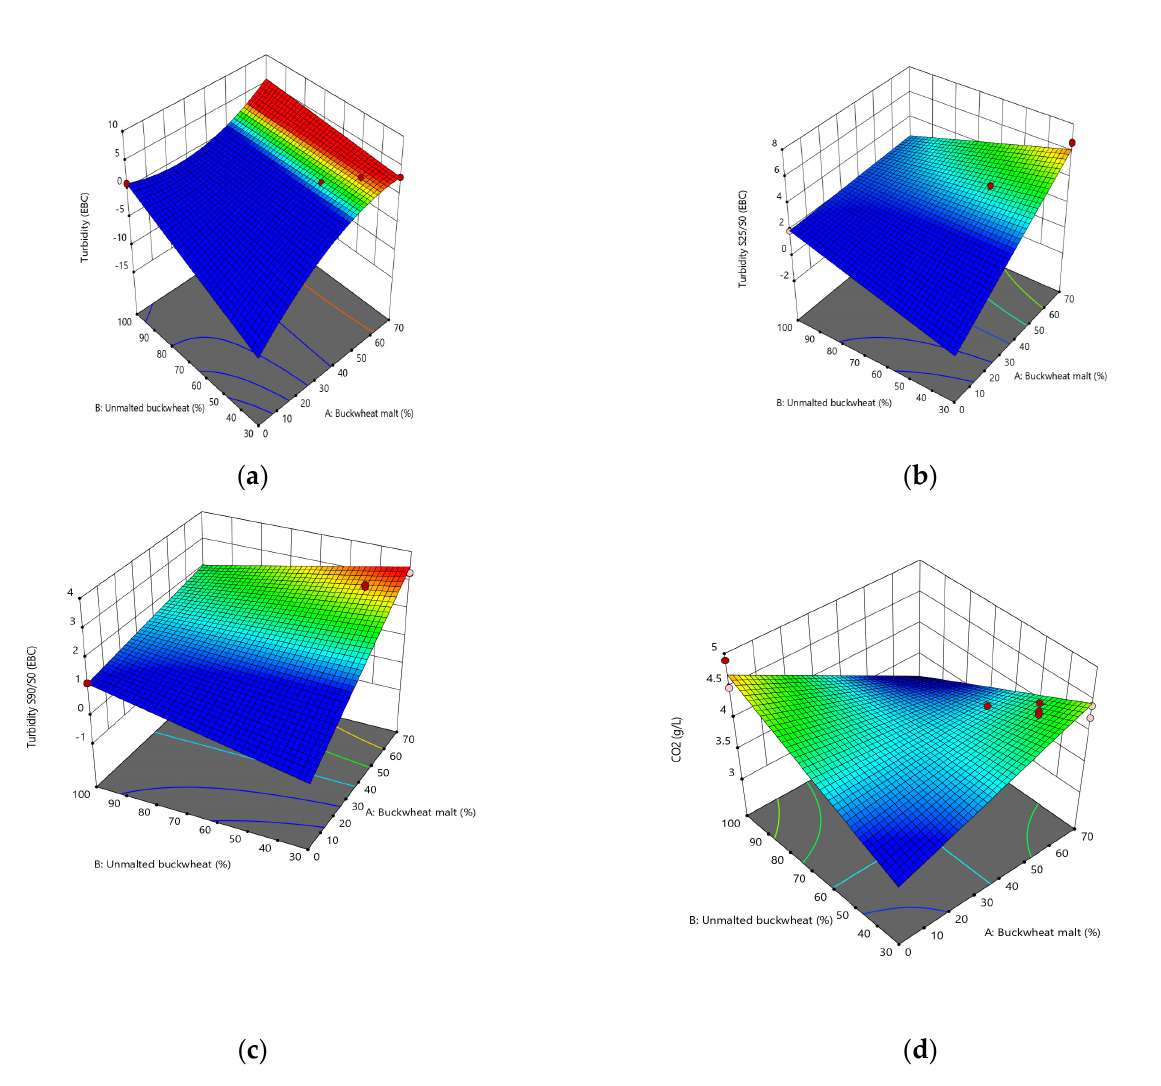
Figure 4. The graphical representations of the beer turbidity ( a ), turbidity S25/S0 ( b ), turbidity S90/S0 ( c ), and carbon dioxide ( d ) as affected by the levels of unmalted buckwheat and buckwheat malt used in a beer recipe.